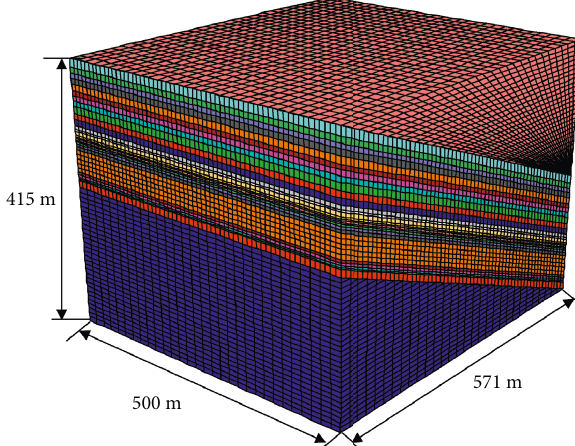
Figure 7: Numerical calculation model